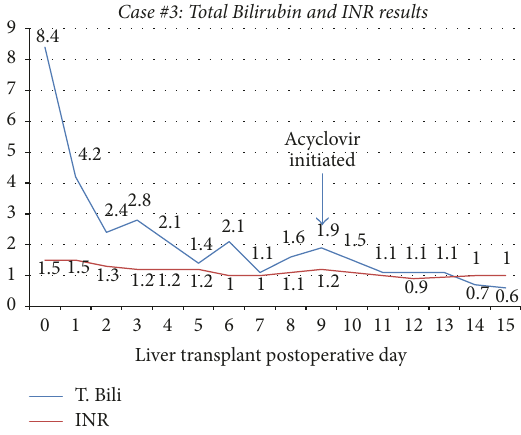
Figure 6: Case #3 trend in Total Bilirubin and INR. T. Bili: Total Bilirubin; INR: International Randomized Ratio.